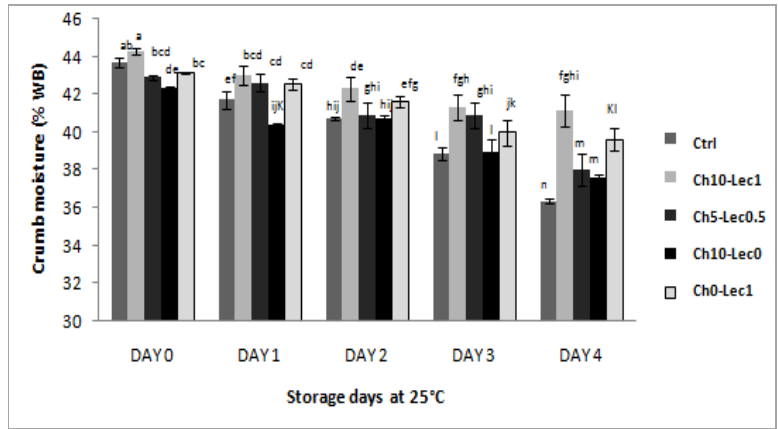
Figure 1 . Crumb moisture of the different formulations during storage at 25 °C. WB: wet basis Figure 1. Crumb moisture of the di ff erent formulations during storage at 25 ◦ C. WB: wet basis. a–h: Bars followed with the same letter are not significantly di ff erent at p < 0.05. Ch10-Lec0, bread with the exclusive addition of chia flour at 10%; Ch0-Lec1, bread with the exclusive addition of soy lecithin at 1%; Ch10-Lec1, bread with the addition of chia flour at 10% and soy lecithin at 1%; Ch5-Lec0.5, bread with the addition of chia flour at 5% and soy lecithin at 0.5%; ctrl, control bread without chia and